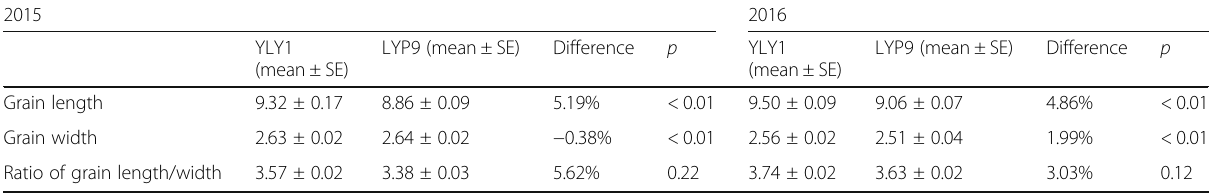
Table 7 The grain length, width and the ratio of length/width were measured by SC-Grice grain appearance quality image analysis system (Hangzhou WSeen Detection Technology Co., Ltd., China) for cv. YLY1 and LYP9 in 2015 and